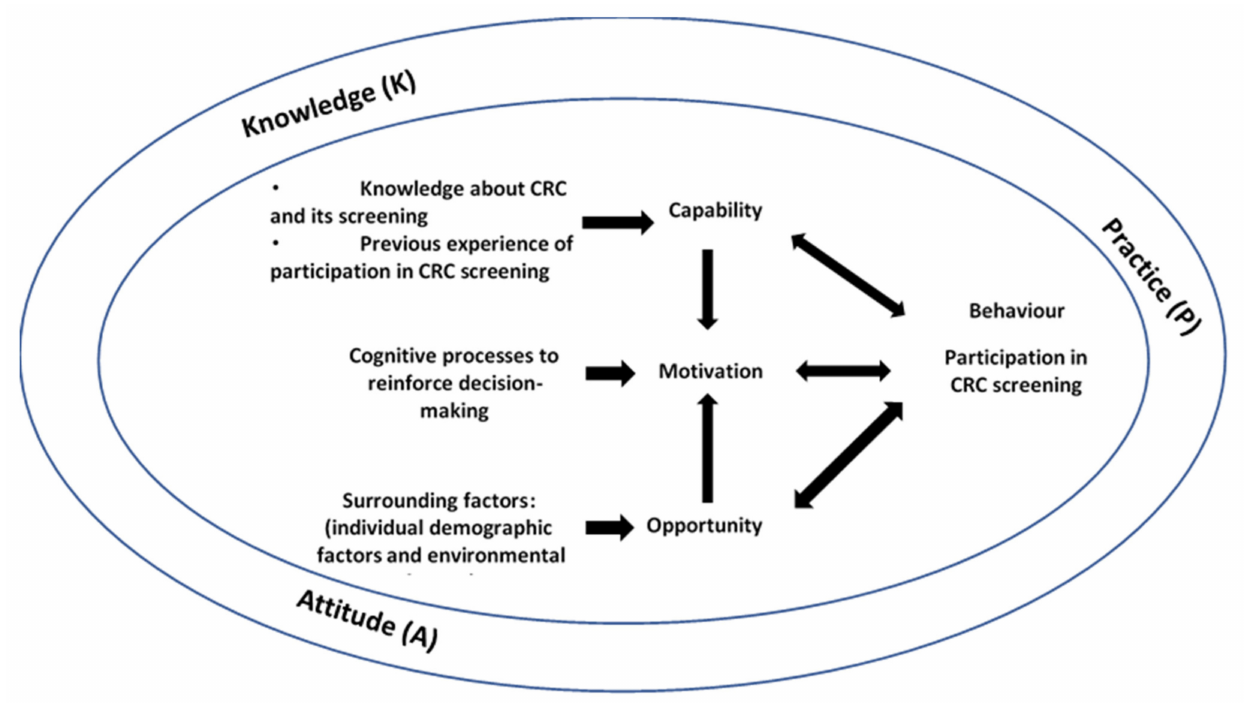
Figure 1. The COM-B model and